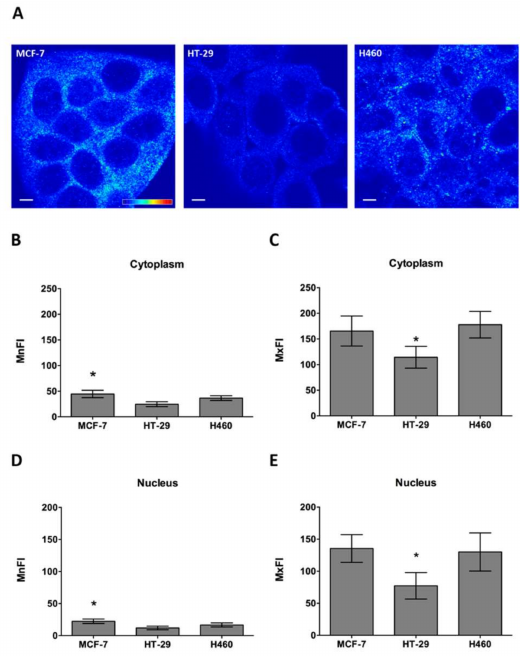
Figure 7. COMMD1 in situ protein levels were evaluated by immunodetection. ( A ) Differences in COMMD1 levels were observed between cell lines using pseudocolor imaging; ( B , D ) Mean fluorescence intensity (MnFI) was measured in both nuclei and cytoplasm of 10 single confocal planes for each cell lines. Results obtained showed that MCF-7 appeared to be the cell line with highest amount of COMMD1, followed by H460, whereas HT-29 displayed the lowest levels of COMMD1 in situ; ( C , E ) Considering the maximum fluorescence intensity values (MxFI), a similar pattern was observed, in which MCF-7 and H460 had the highest amount of COMMD1, both at the cytoplasm and nuclei (scale bar = 10 µ m). * Mann-Whitney U Test, p <